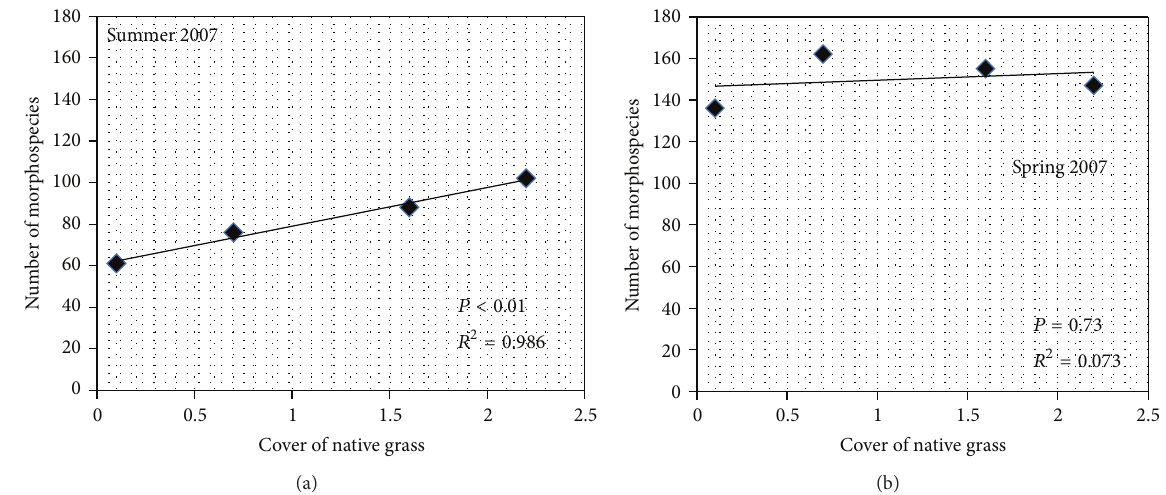
Figure 4: Examples of pairwise regressions of richness, from both capture methods, on cover of native grass. (a) February 2007 (regression ANOVA; 𝐹 1,2 = 134.6 , 𝑃 < 0.01 ) and (b) October 2007 ( 𝐹 1,2 = 0.16 , 𝑃 = 0.73 ).